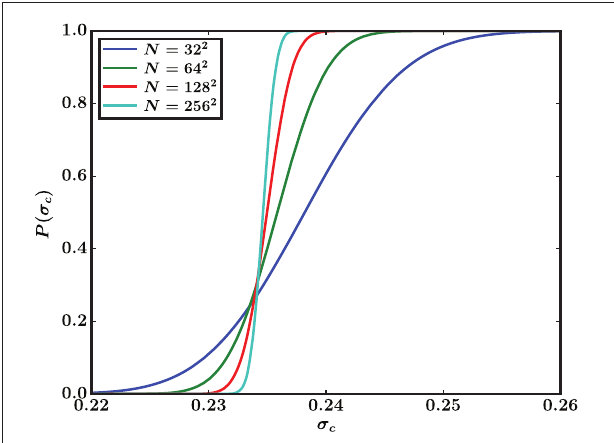
FIGURE 5 | Cumulative distribution of critical damage P ( d c ) for LLS on a square lattice. The number of samples is 8 × 10 5 , 2 × 10 5 , 10 5 , and 3 × 10 4 for system sizes N = 32 2 , 64 2 , 128 2 , and 256 2 , respectively. The threshold distribution is uniform: P ( t ) = t .